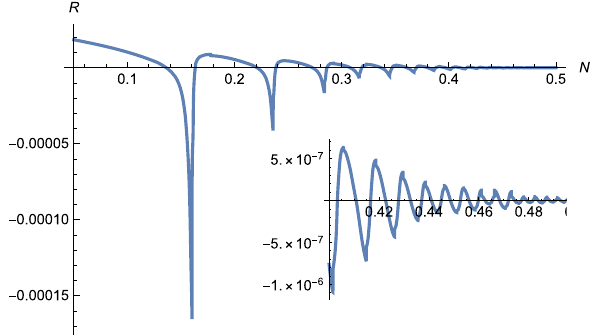
Fig. 10 The evolution of Ricci scalar during the oscillatory period. The oscillations tend to be damping sinusoidal for smaller amplitudes